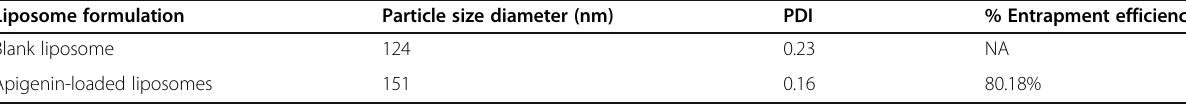
Table 8 Results of characterization of apigenin-entrapped liposomes Liposome